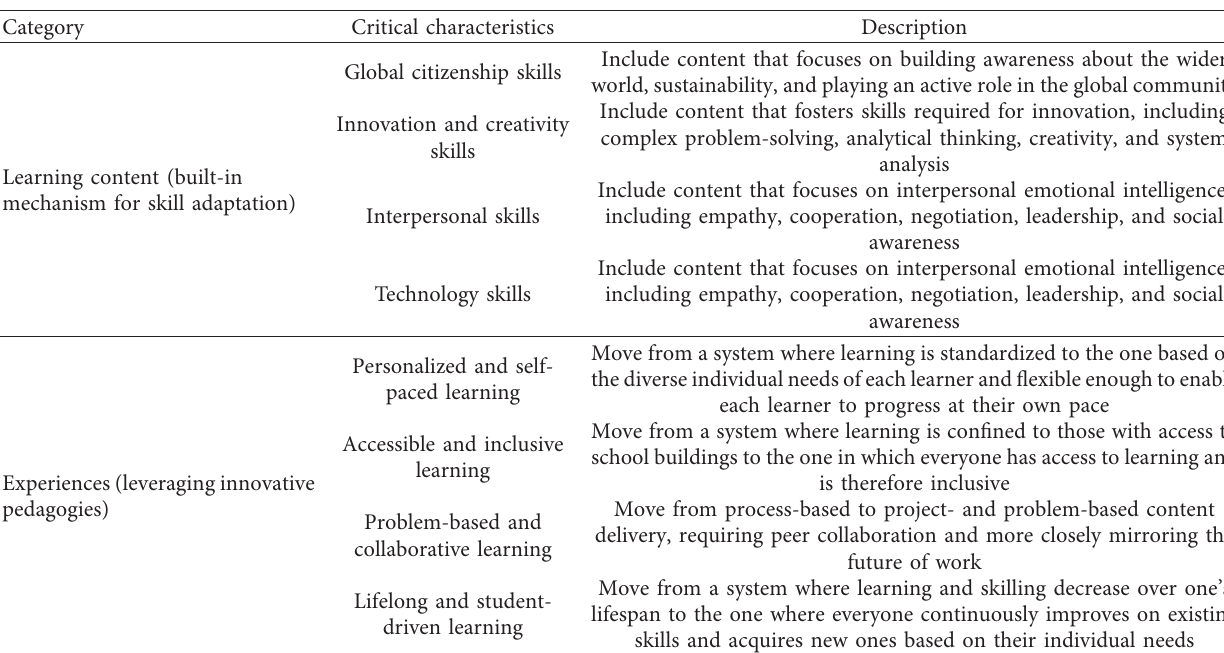
Table 4: Education 4.0